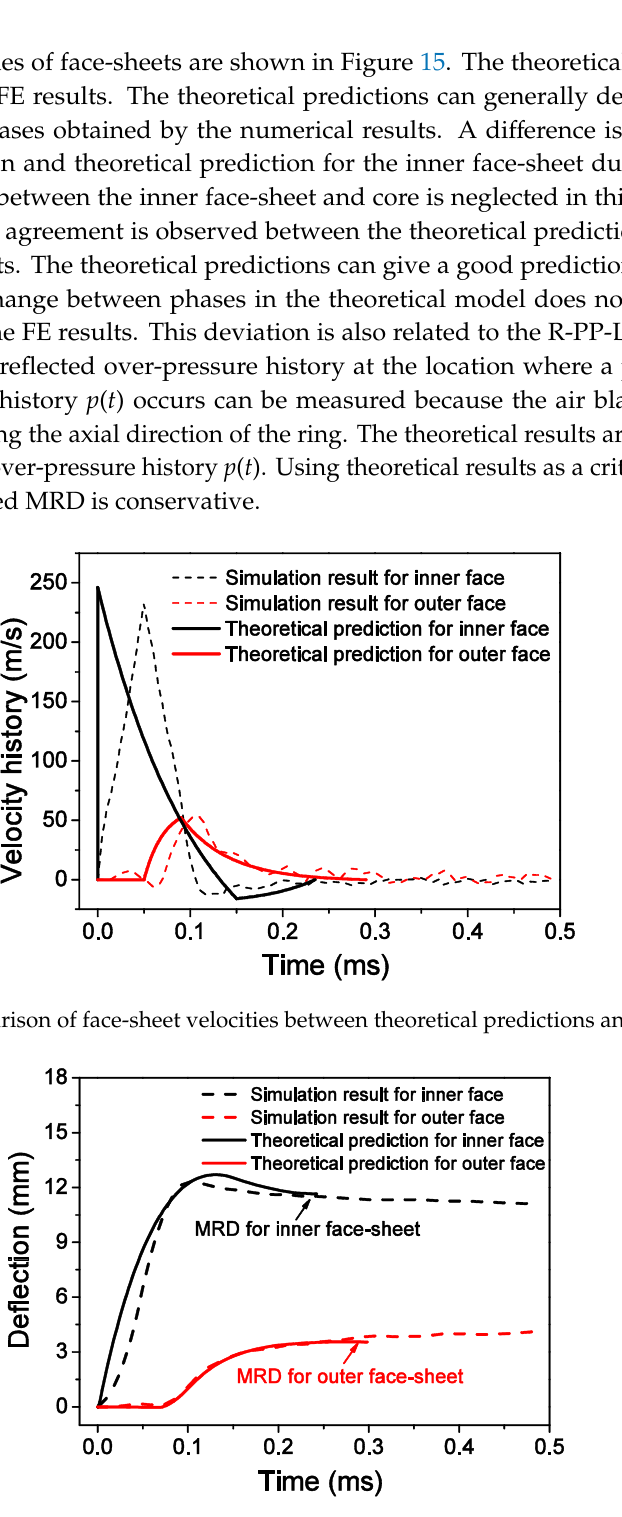
Figure 16. Comparison of maximum radial deflections (MRDs) of face-sheets between theoretical predictions and FE results.